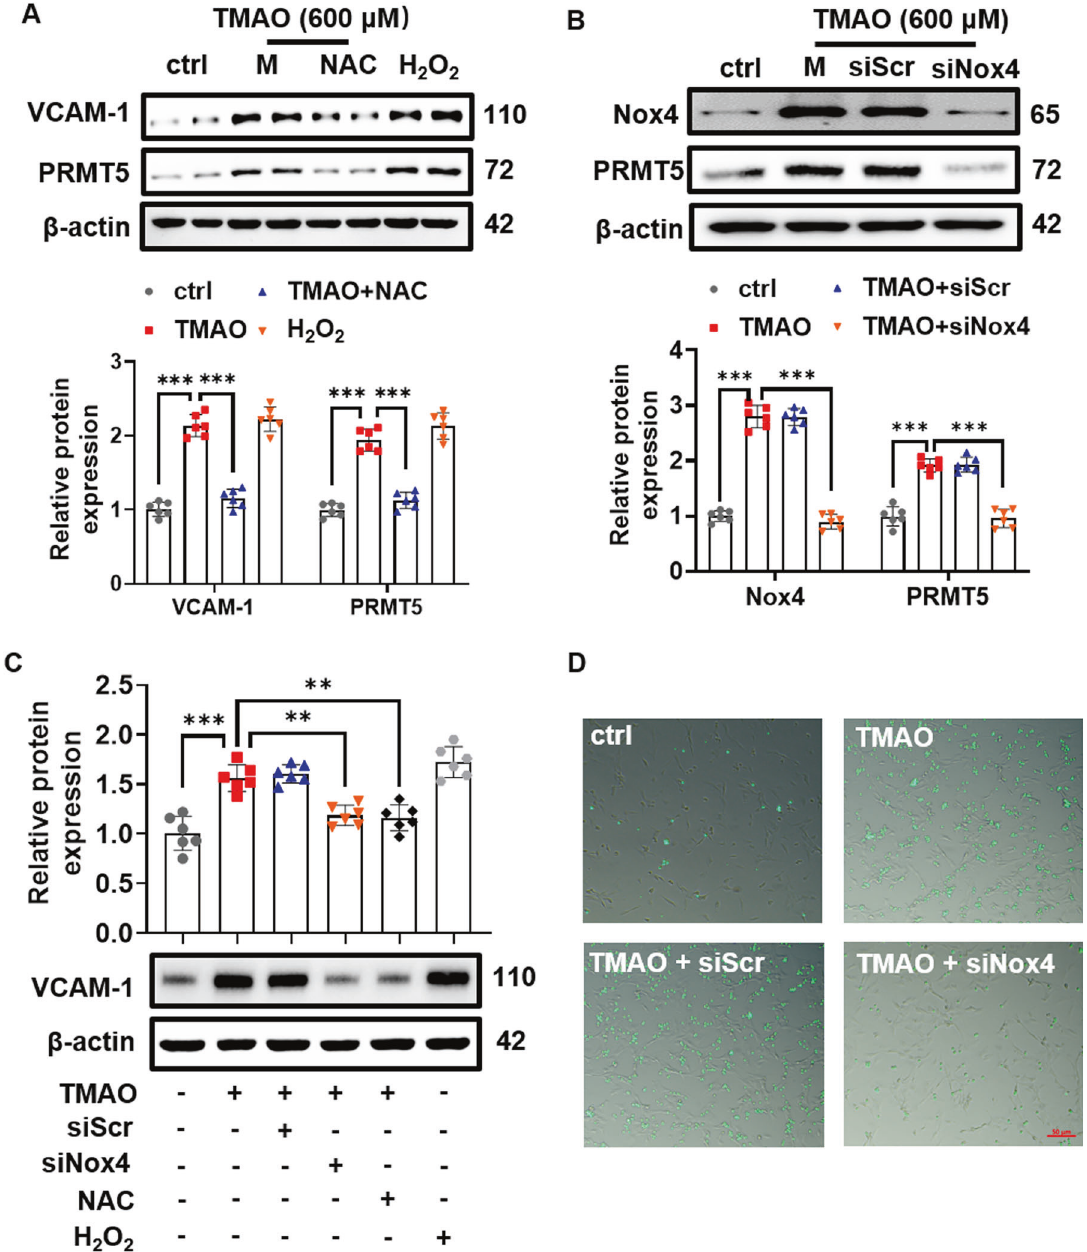
Fig. 6 Nox4 knockdown downregulates PRMT5 and VCAM-1 expression. A VSMC were pretreated with N-acetyl-cysteine (NAC) and then stimulated with TMAO (600 μ M) for 24 h. Representative blots and quantitative analysis of VCAM-1 and PRMT5. The protein expression level was normalized to β -actin. H 2 O 2 stimulation served as positive control. B – D VSMC were treated with scrambled siRNA (siScr) or Nox4 siRNA (siNOX4) and then treated with TMAO (600 μ M). B Representative blots and quantitative analysis of Nox4 and PRMT5. The protein expression level was normalized to β -actin. C Representative blots and quantitative data of VCAM-1 protein expression. The protein expression level was normalized to β -actin. H 2 O 2 stimulation served as positive control. D Representative images obtained by fl uorescence microscope show cell adhesion. Data shown are means ± SD, n = 6 per group from three independent experiments. ** P < 0.01, *** P < 0.001 using a one-way ANOVA followed by Tukey ’ s post hoc